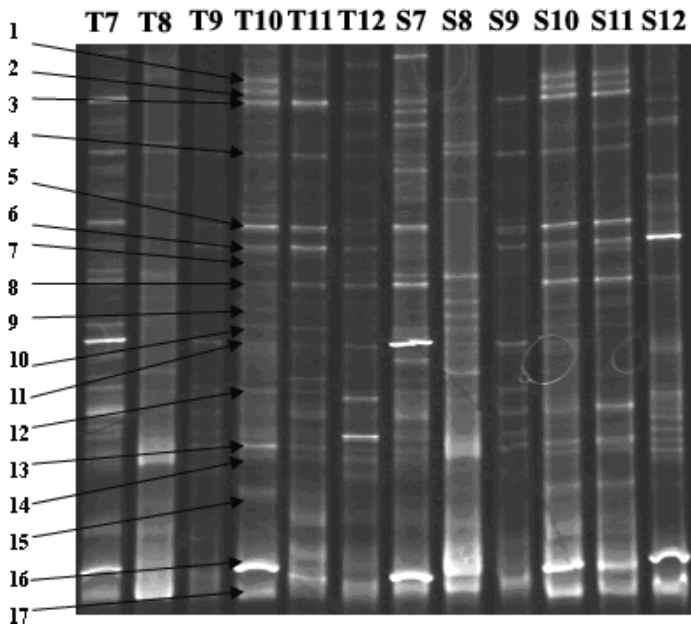
Figure 2. The PCR-DGGE fingerprint map of water samples from July to December 2007 in Tiegang and Shiyan Reservoir. T7-T12: samples from July to December in Tiegang Reservoir; S7-S12: samples from July to December in Shiyan